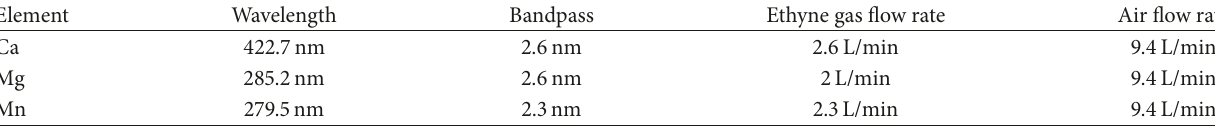
Table 3: Main measurement parameters for Ca, Mg, and